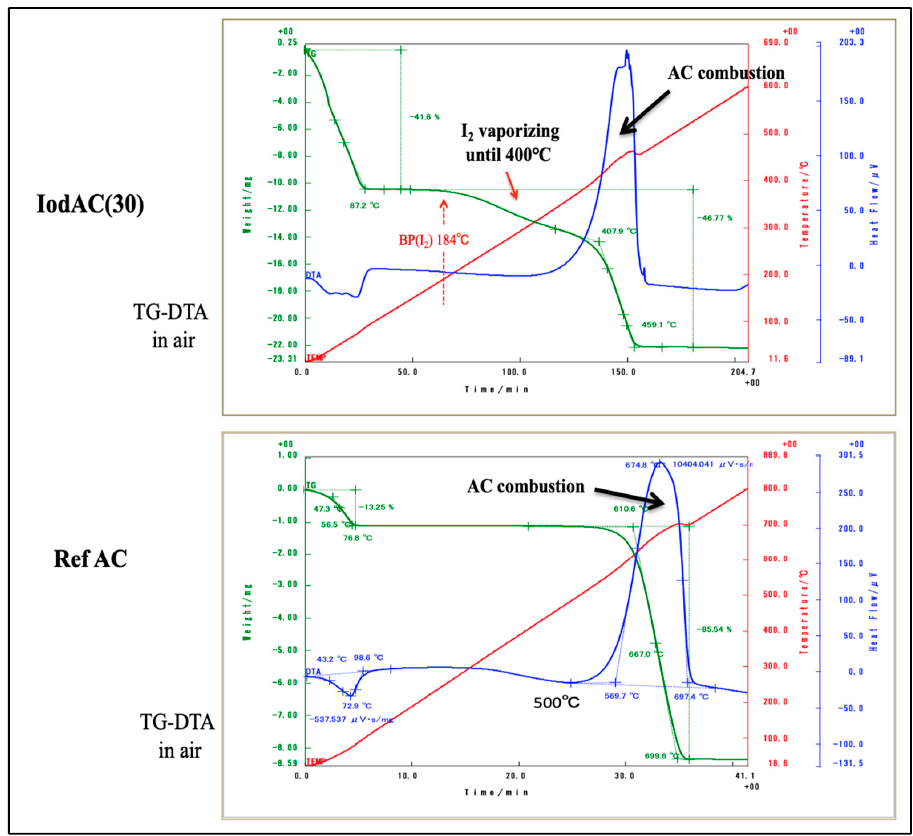
Figure 2. Characterization of IodAC by ThermoGravimetry-Differential Thermal Analysis (TG–DTA) and comparison with raw (not treated with iodine) AC (referred to as “Ref AC”). Analysis performed using a Thermo Plus2 TG8120 (Rigaku, Tokyo, Japan).